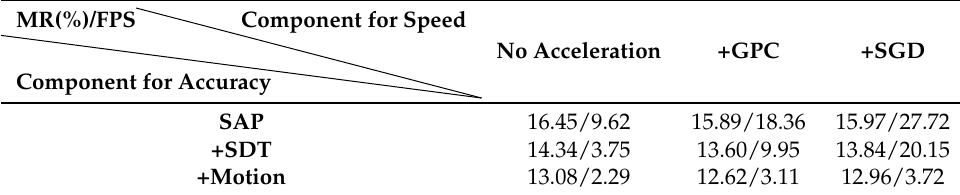
Table 3. MR and FPS on Caltech test set under different setups of our